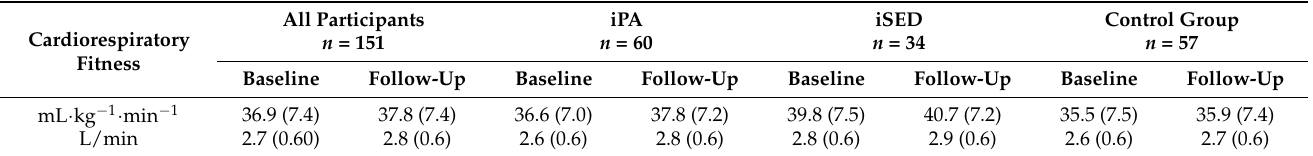
Table 4. Baseline and 6-month follow-up values for cardiorespiratory fitness (mean (SD)). Cardiorespiratory Fitness